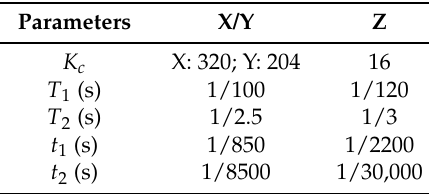
Table 4. Deign parameters of the three-axis controllers in vacuum.